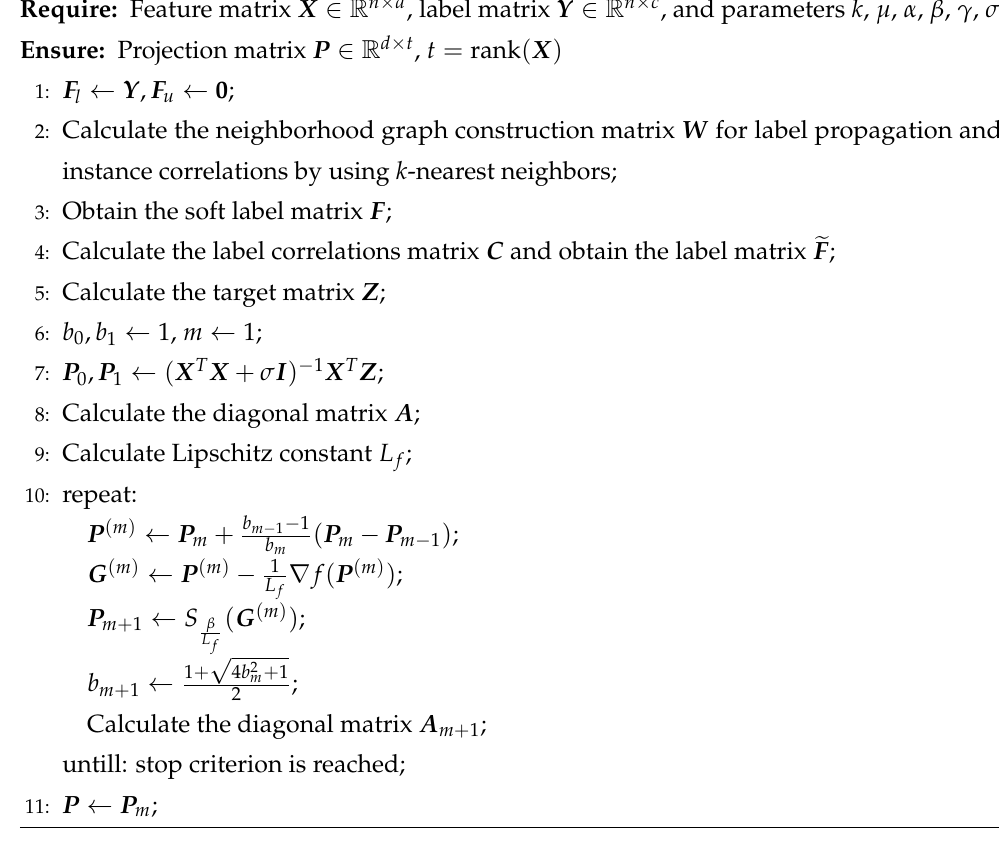
Algorithm 1 SMDR-IC: Semi-supervised Multi-label Dimensionality Reduction Learning by Instance and Label Correlations